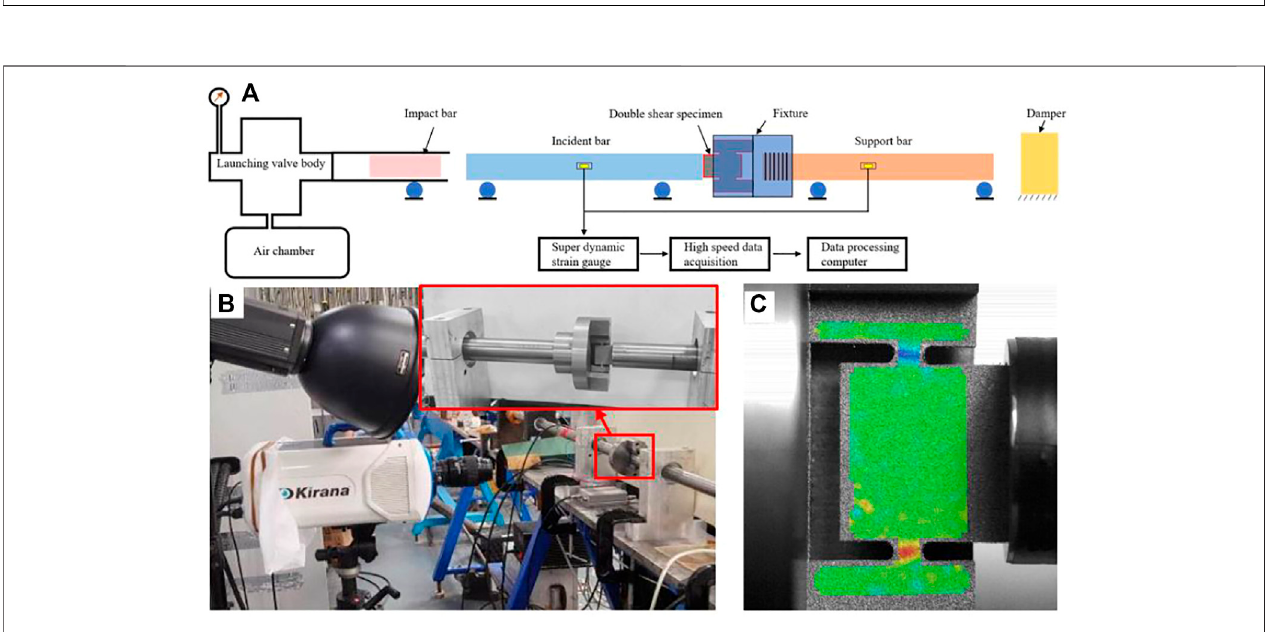
FIGURE 4 | SHPB test device: (A) SHPB schematic diagram, (B) ultra-high-speed camera recording system, and (C) shear strain fi eld on the specimen surface.